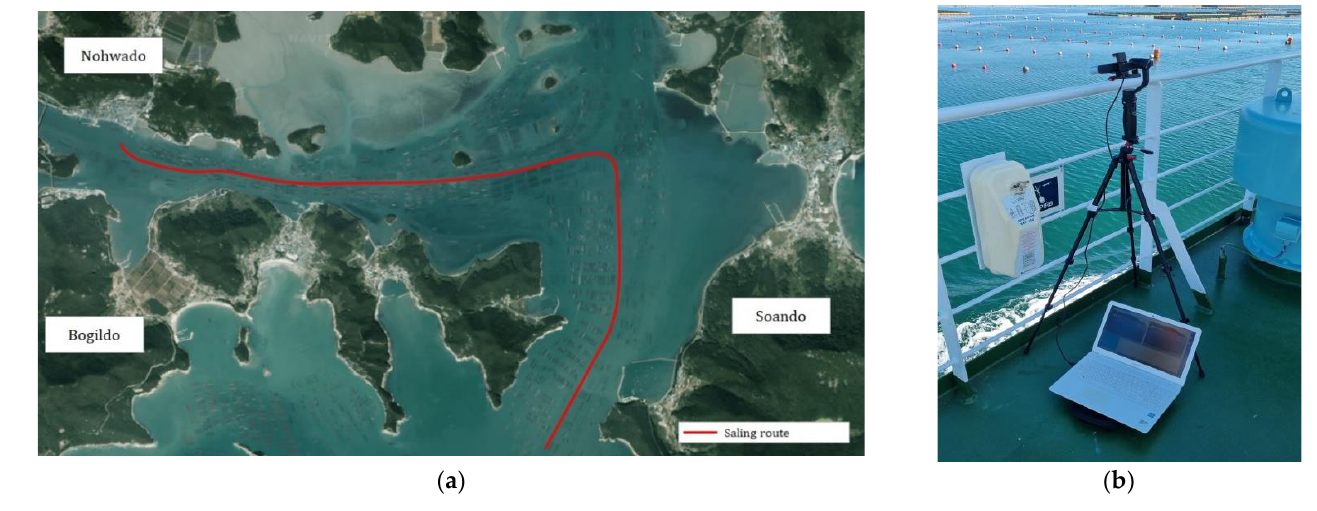
Figure 10. Experimental site ( a ) and equipment ( b ).